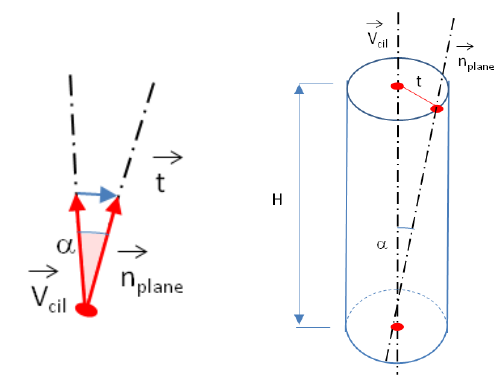
Fig. 6. Misalignment t and versors angle α .